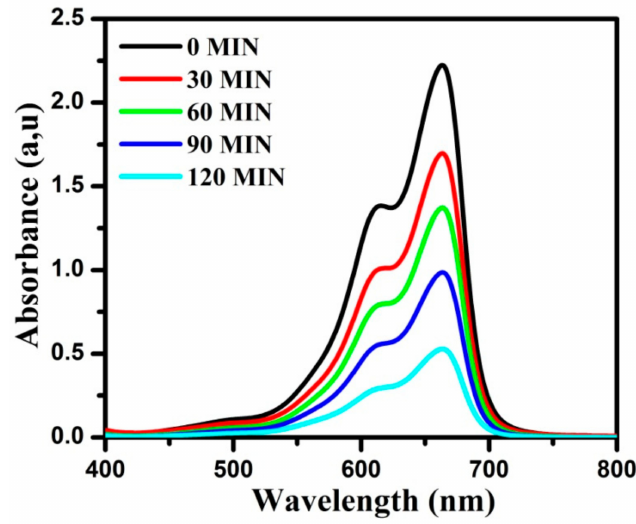
Figure 9. Photocatalytic degradation spectrum of FNH nanoparticles.